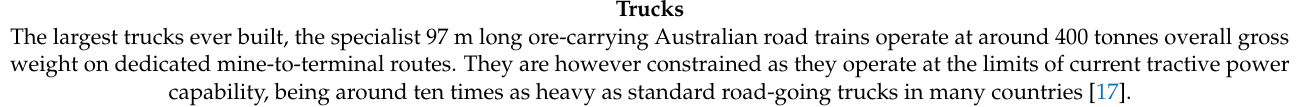
Table 2. Capability of transport